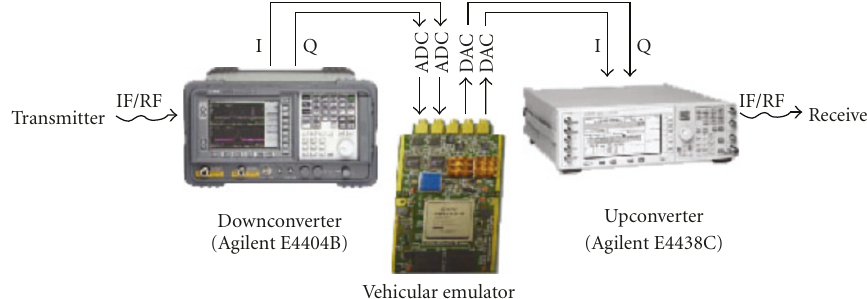
Figure 2: Hardware set-up for testing an IEEE 802.11p physical transceiver with IF/RF outputs on our real-time channel